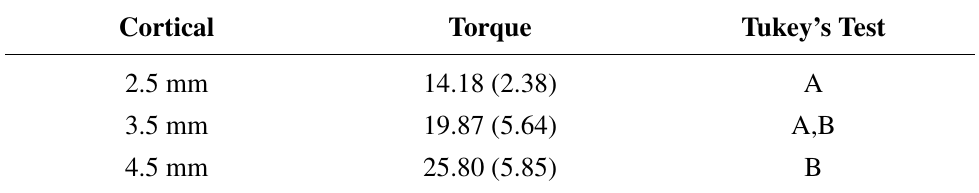
Table 2. Mean values torque (N ¨ cm), standard deviations (SD) and cortical thickness (mm) influence of 6 mm length screw placed into bovine femur.